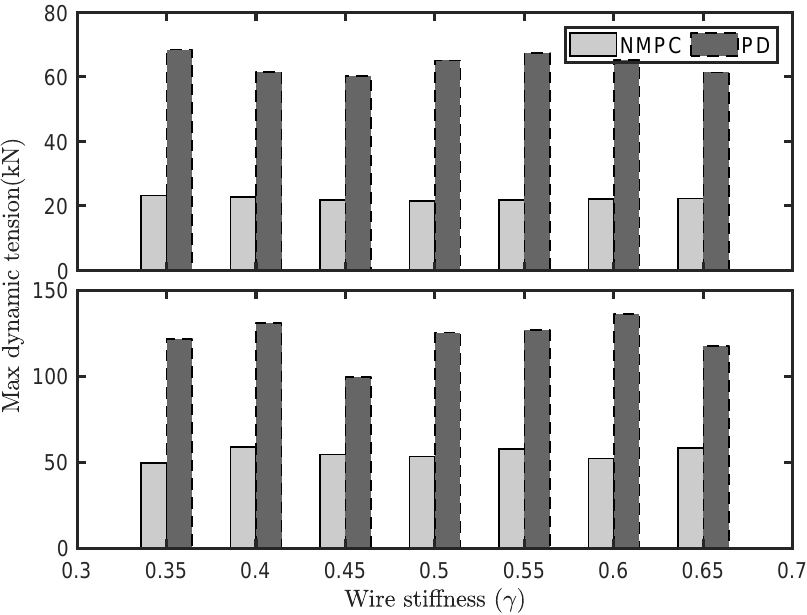
Figure 15. Comparison of the maximum dynamic tensions resulted by the NMPC and PD controllers, mean wind speed = 0 m/s (upper: Region I, lower: Region